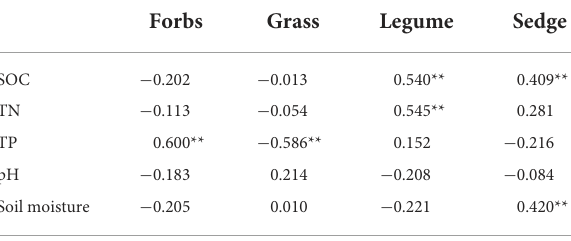
TABLE 3 Correlation analysis of PFGs and soil physical and chemical index. Forbs Grass Legume